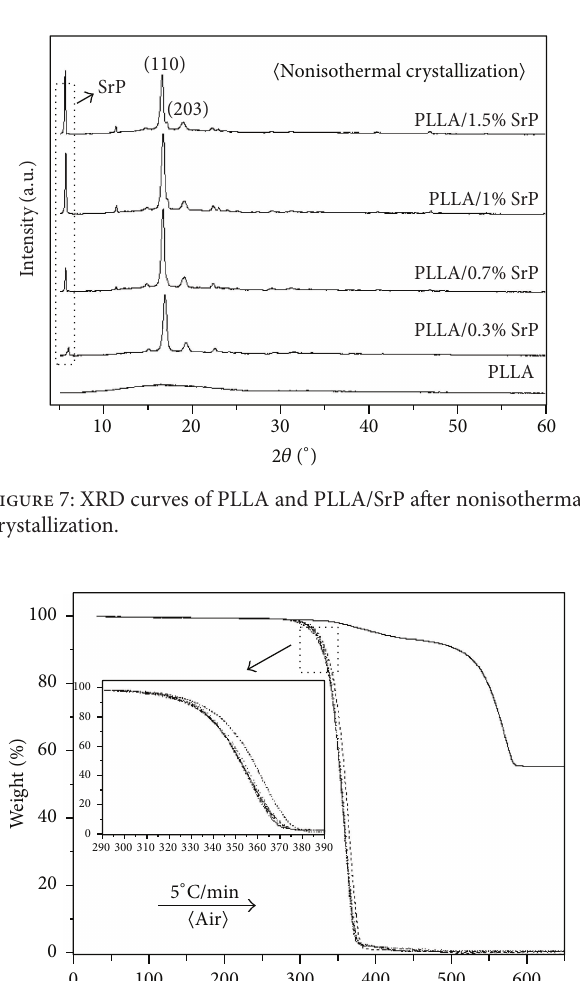
Figure 8: TGA curves of SrP, PLLA, and PLLA/SrP. onset decomposition temperature of the PLLA to